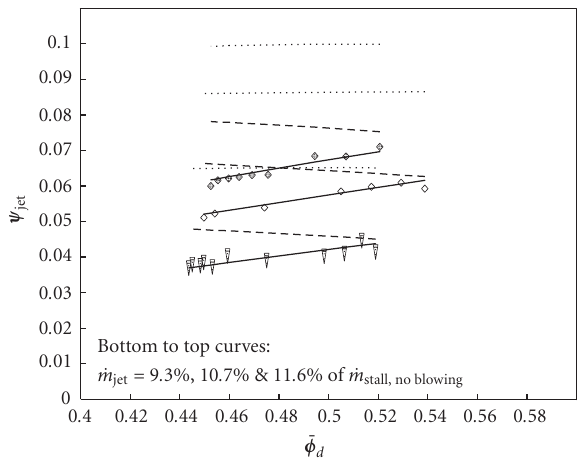
Figure 7: Jet contribution ( ψ jet ) to ψ (actuator+compressor) (points) and fit (solid lines) versus full-mixing model (dashed lines) and pure momentum addition model (dotted lines).